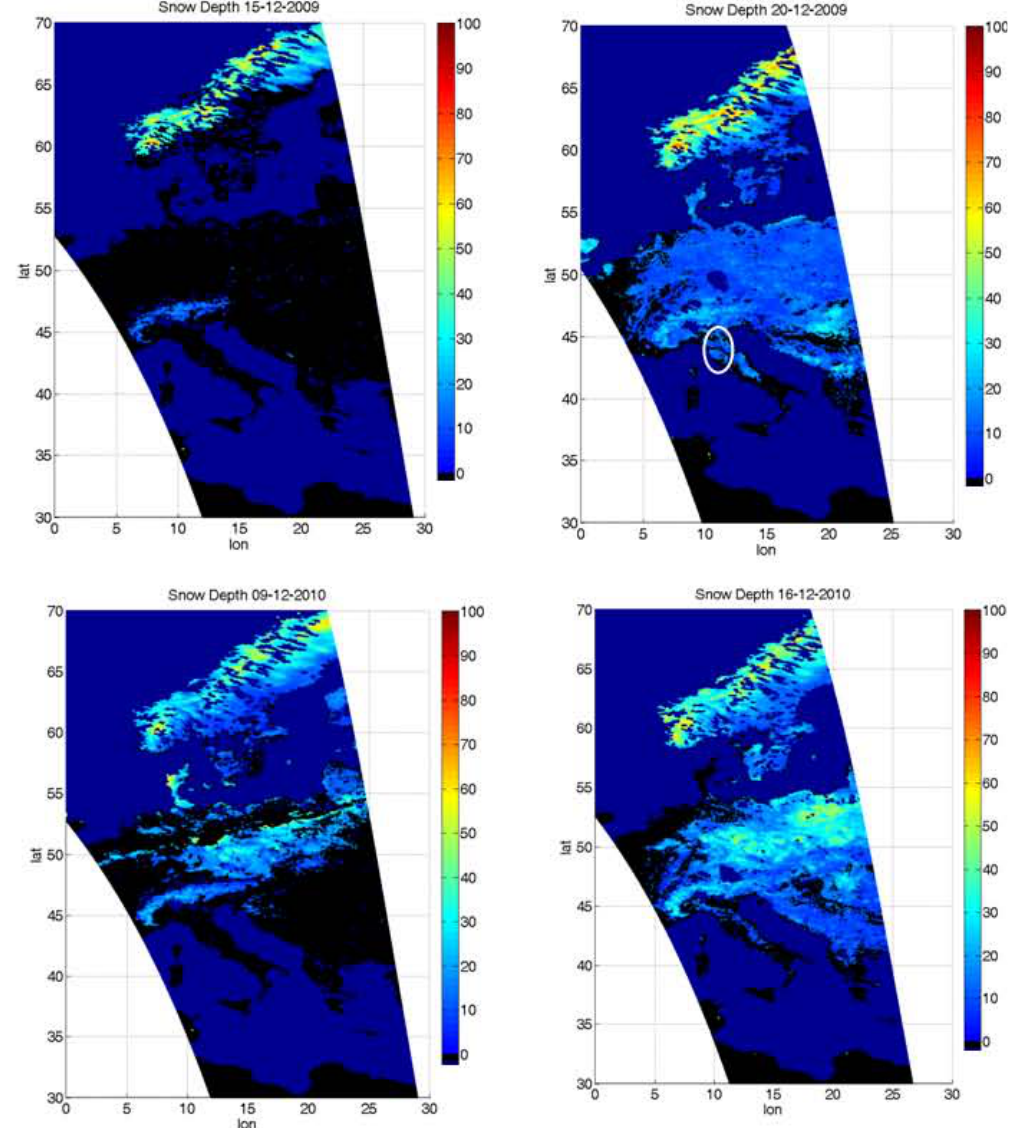
Fig. 13. SD maps (in cm) retrieved on Europe before and after heavy snowfall events in December 2009 and 2010. On 15 December 2009 and 9 December 2010 the snow cover is sparse and almost limited to Scandinavia and Alps, whereas, after the events, the snow cover appears to be much more spread and evident even in Central Italy, where the snow depth measured on 20 December 2009 in the area close to Florence (white circle) was about 10cm on the ground, which is the value estimated by the